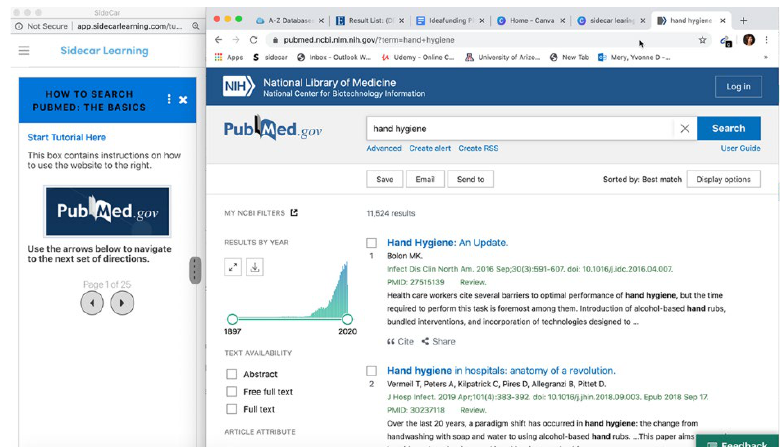
Figure 2 Sidecar Learning